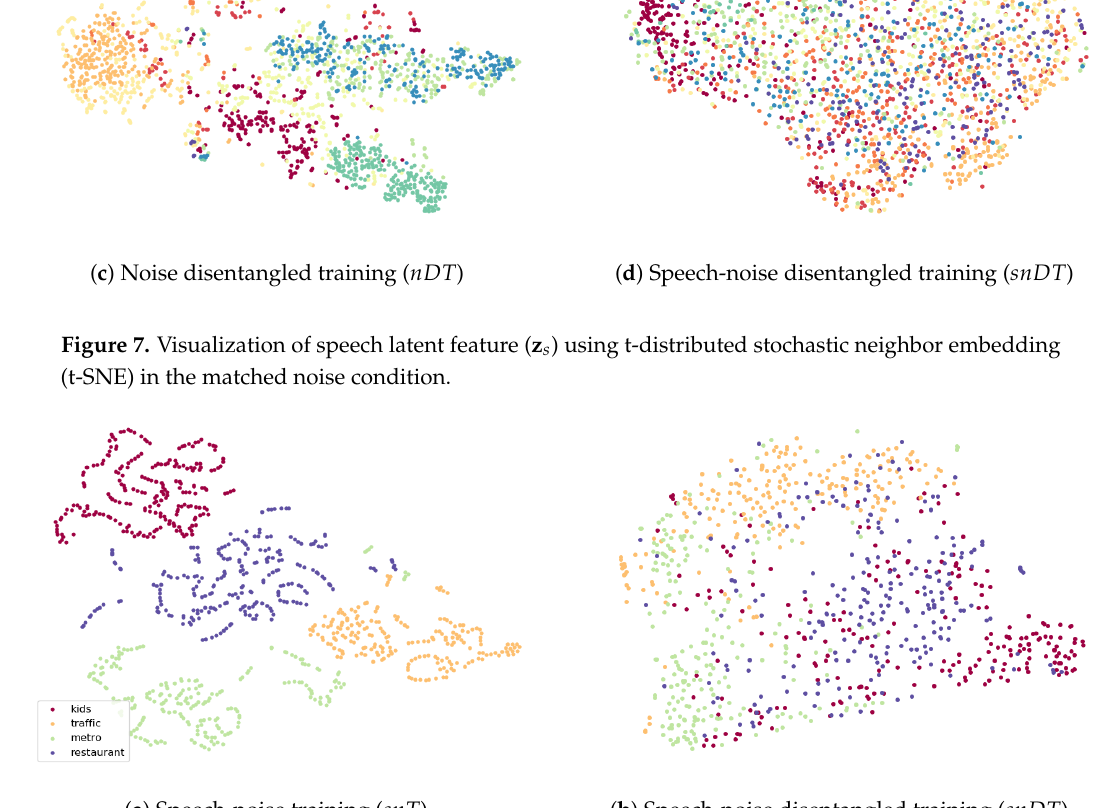
Figure 8. Visualization of speech latent feature ( z s ) using t-SNE in the mismatched noise